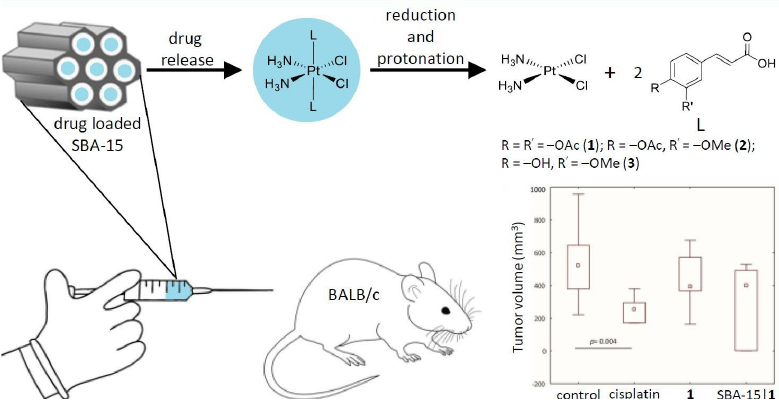
Figure 3. Vehiculation of platinum(IV) derivatives in SBA − 15 showing strong antitumor activity in mice with breast cancer [50]. Representation of the adsorption and release of platinum compounds and their effect of tumors’ growth suppression in a mouse model. Copyright © Authors of the publication (open access).